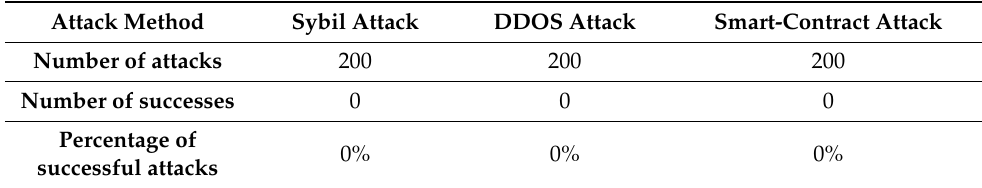
Table 3. Attack test